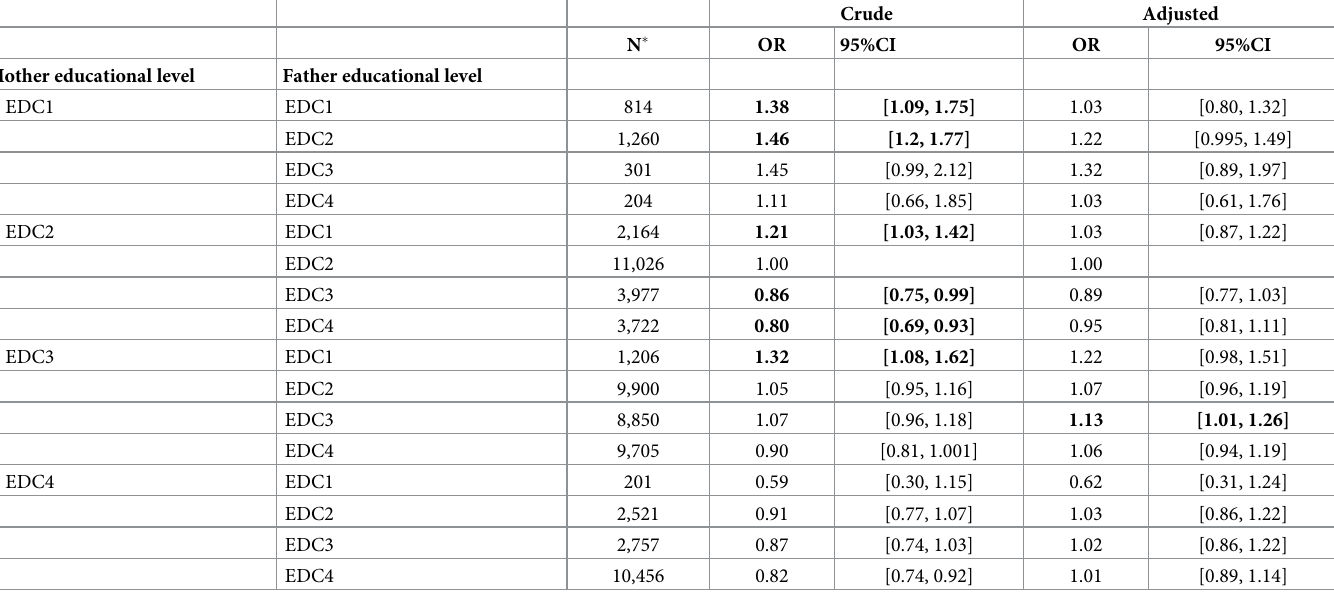
Table 5. Crude and adjusted odds ratios of the combination of mother’s and father’s education for doctor-diagnosed asthma in multilevel logistic regression analy- sis (multiple imputation, N =